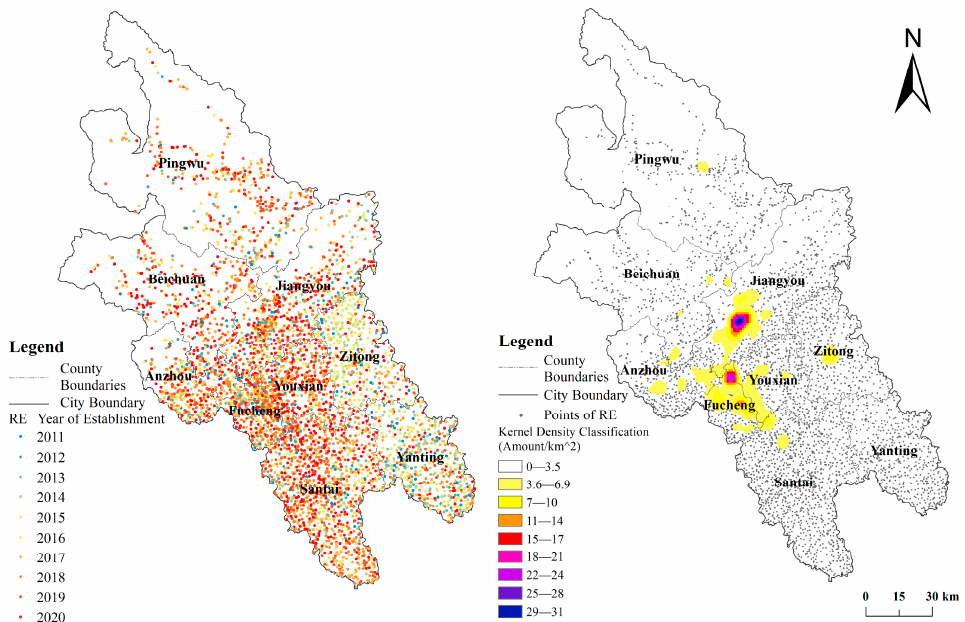
Figure 2. Spatial distribution ( left panel) and Kernel density distribution ( right panel) of rural en- trepreneurship in Mianyang from 2011 to 2020.